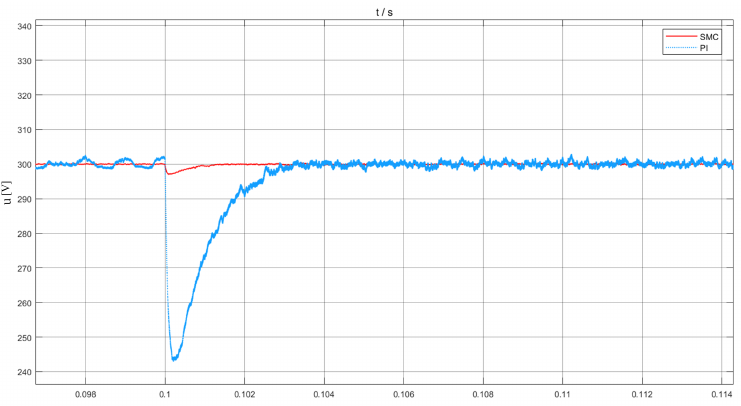
Figure 13. Output voltage response curve after load